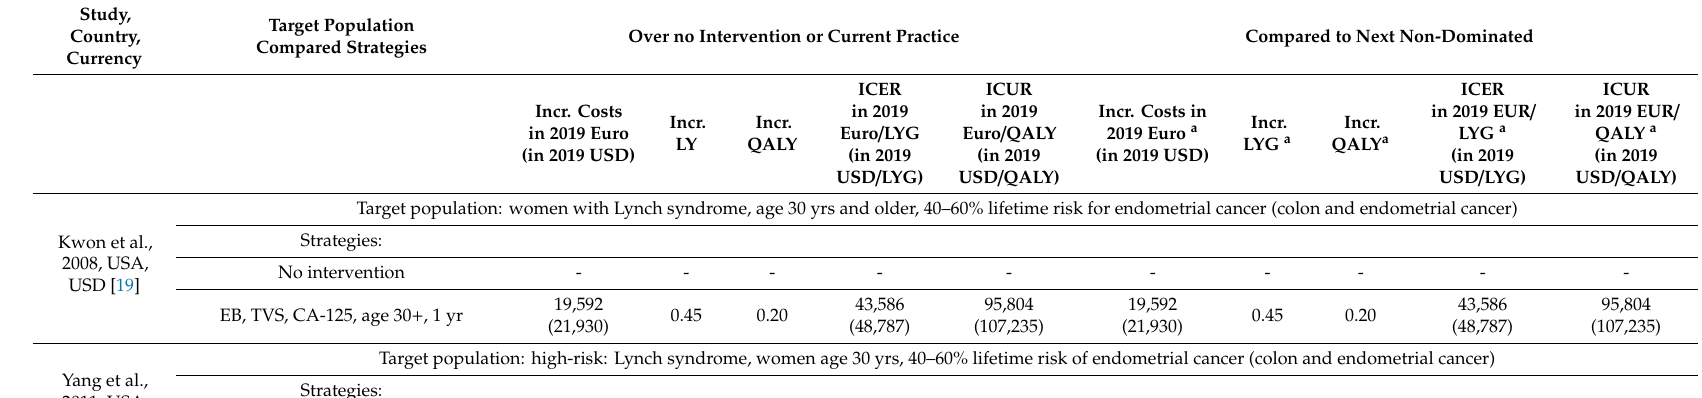
Table 3. Discounted Costs, Life Years, Quality-Adjusted Life-Years (QALYs), and Incremental Cost-E ff ectiveness Ratios of Endometrial Cancer Screening Strategies in Women with Di ff erent Risk